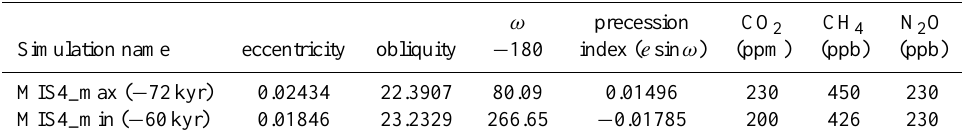
Table 1. Earth’s orbital parameters and greenhouse concentration values for the two MIS4 IPSL_CM5A simulations. ω stands for the longitude of the perihelion and e for the